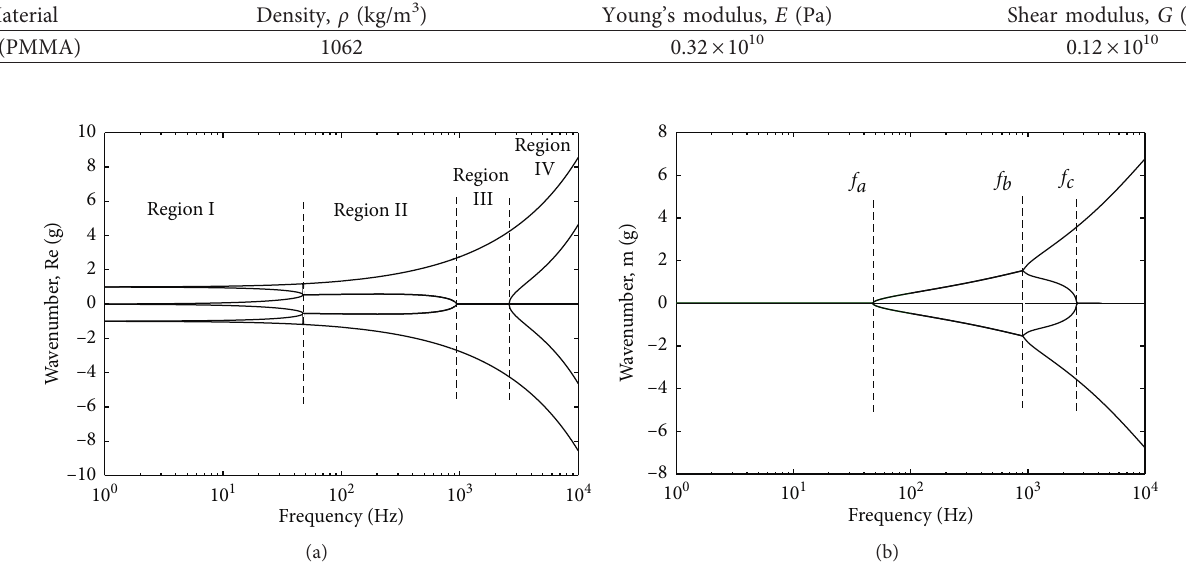
Table 1: Material parameters.